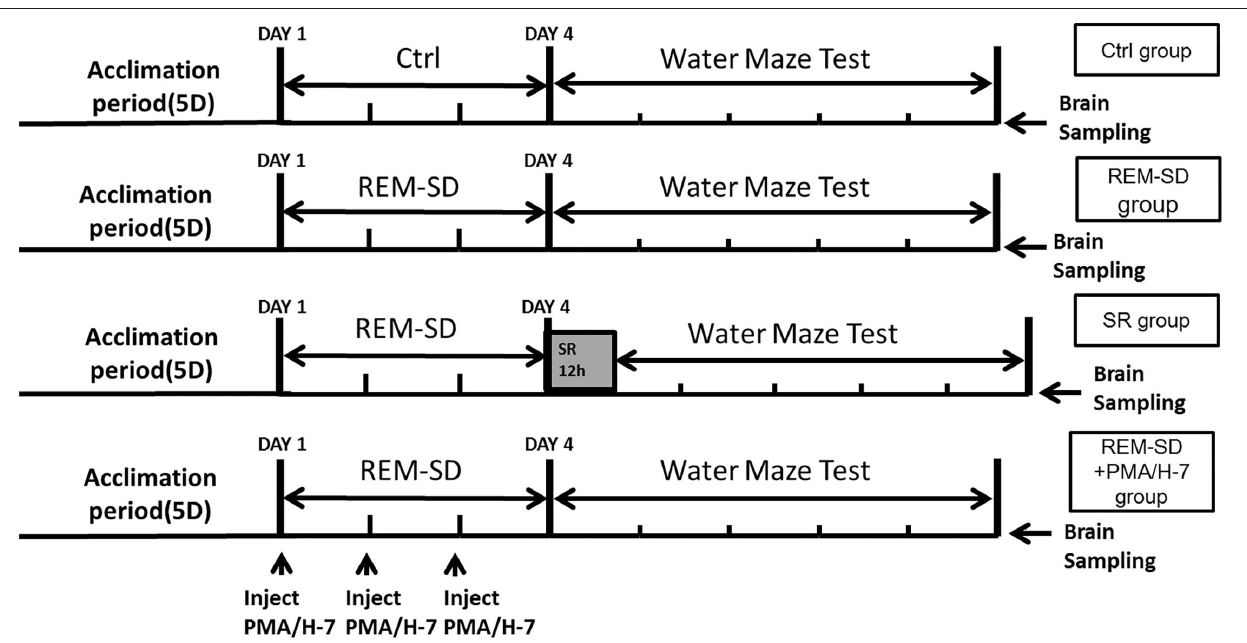
FIGURE 1 | Overview of the experimental